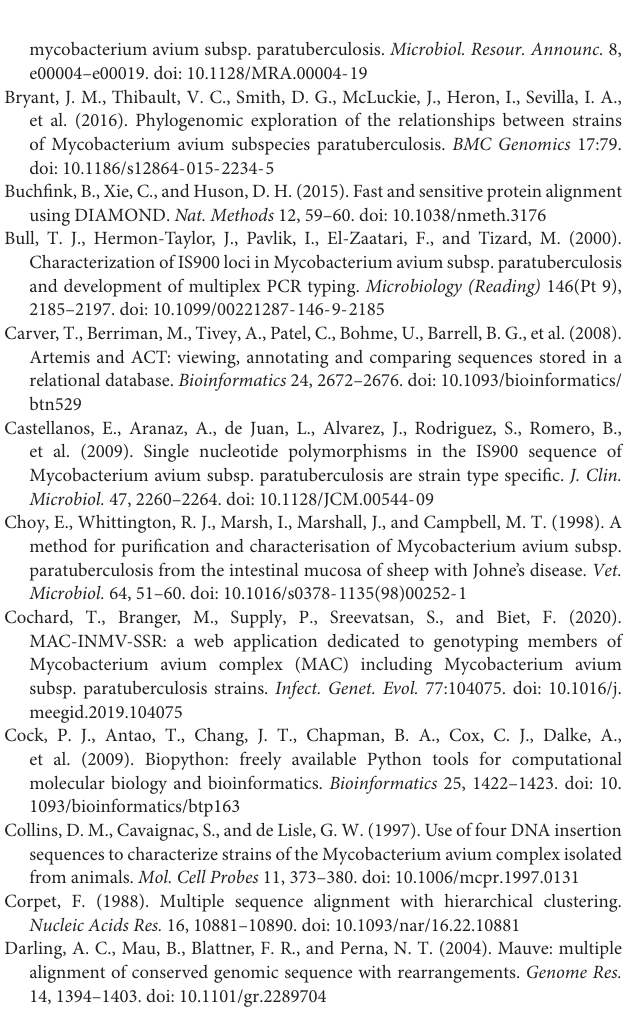
Supplementary Figure 2 | MEME motif of putative IS 900 insertion site extract from Mah 104 genome. Upstream and downstream region extracted from K-10, S397, and Telford genomes were aligned to the Mah 104 genome to find orthologous loci. Sequence of 14 to 17 bp present at conserved orthologous loci in the Mah 104 genome were extracted and MEME was used to discover conserved motif. Supplementary Figure 3 | Detail of the genes surrounding all the IS 900 loci. Representation of IS 900 loci environment. Gene present 7500-bp upstream and downstream of each IS 900 copies were considered. Gray box represents blastn IS 900 hits. Presence of hed gene was indicated when a RBS was found upstream the gene (symbolized by a chevron). The first genes upstream and downstream IS 900 copies were color filled according to their COG functional categories. Pseudo genes were indicated in black. Supplementary Table 1 | Detail of all orthologous loci. Supplementary Table 2 | IS 900 orthologous sites and orthologous loci between the three Map genomes. Supplementary Table 3 | IS 900 orthologous analysis across all complete